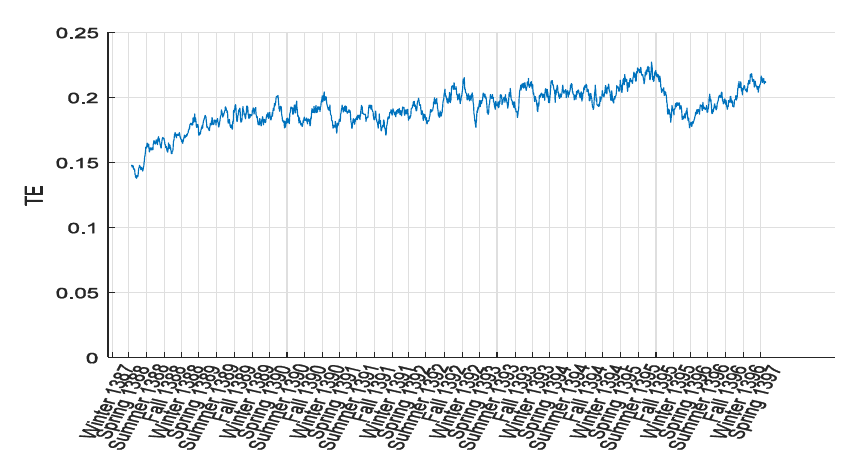
Figure 6. Average transfer entropy or average information transferred 180 companies in Tehran Stock Exchange